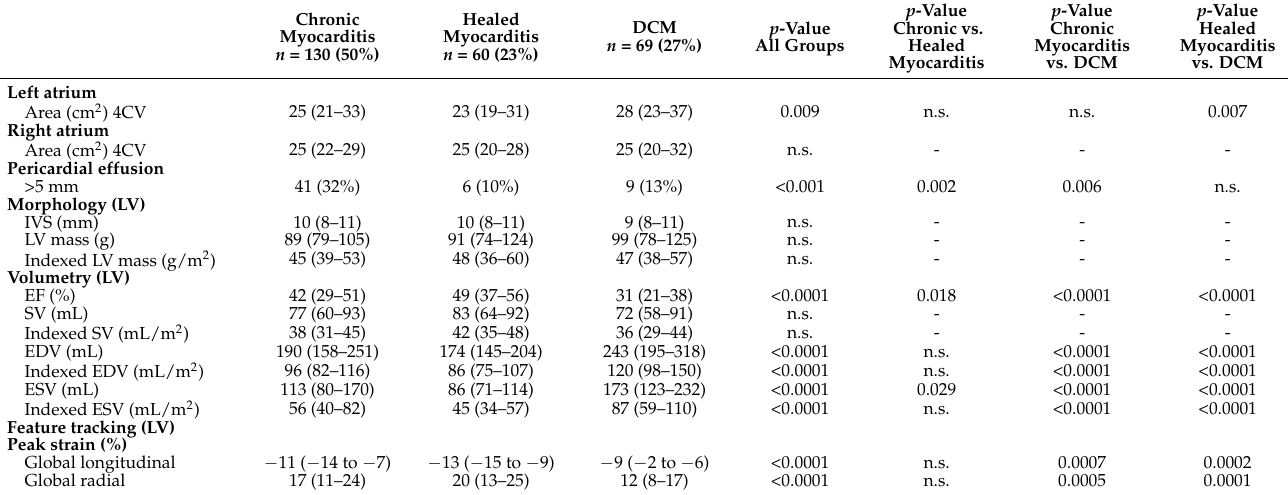
Table 2. CMR Results in Chronic and Healed Myocarditis as well as